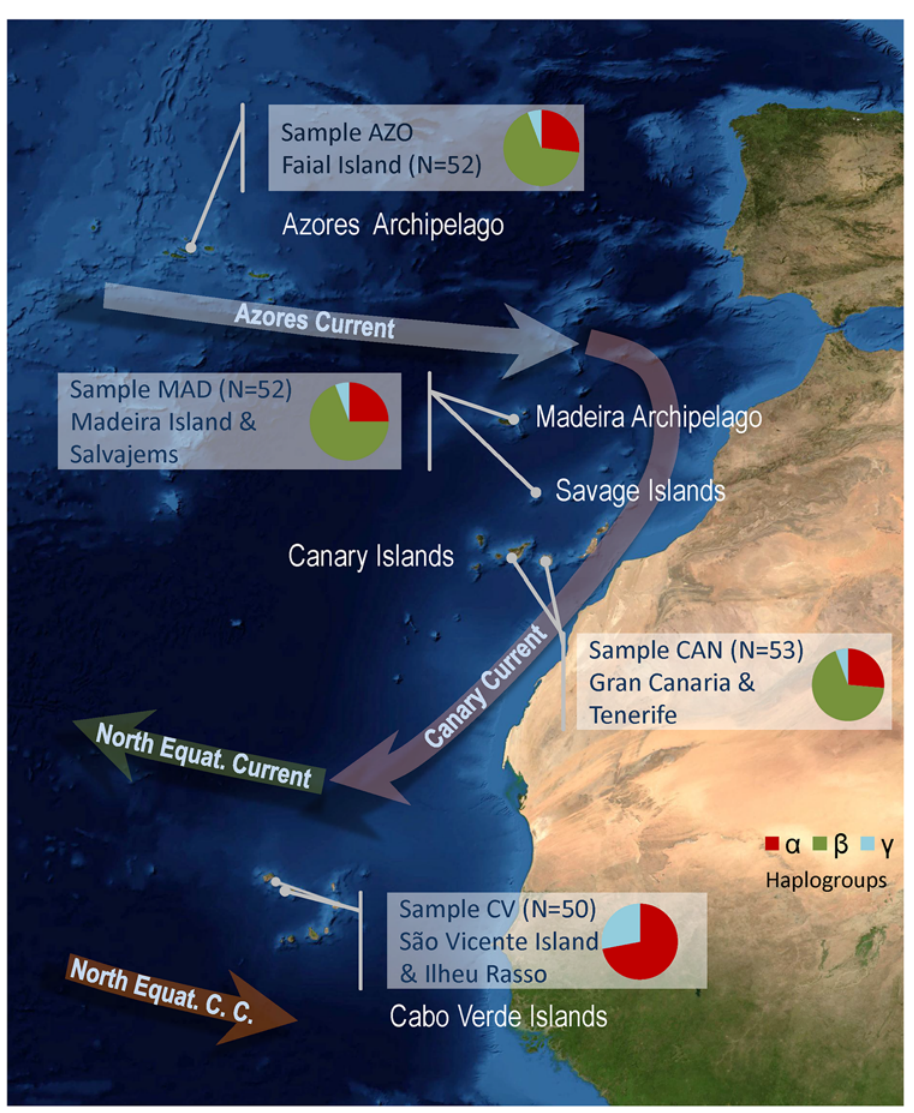
Fig 1. Sampling locations and haplogroup frequencies. Image (NASA) of the north-eastern Atlantic area indicating the sampling locations for each of the Macaronesian archipelagos. Arrows indicate the main surface currents and their directions. Haplogroup ( α , β , and γ ) frequencies estimated for each sampling site are presented in pie charts.